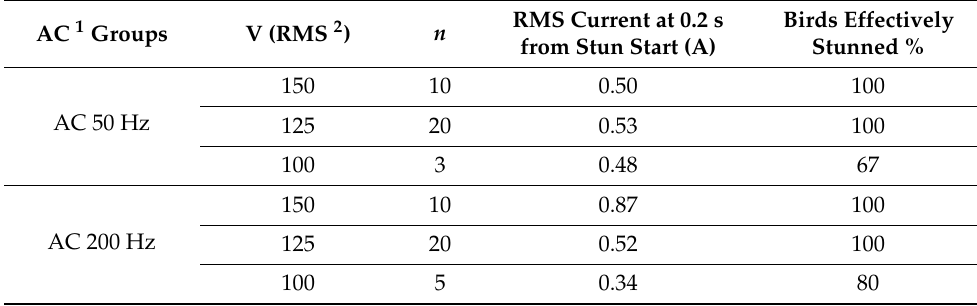
Table 2. Mean average current values for the first 200 ms and the effectiveness of head-only stunning, subjectively